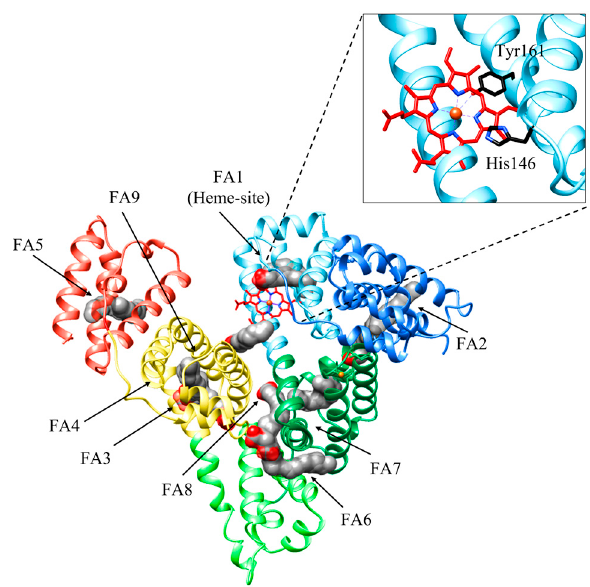
Figure 2. Three-dimensional structure of HSA bound to fatty acids (FAs) and heme. HSA is organized in three domains: domain IA (light blue), domain IB (sky blue), and domain IA (forest green); domain IIA (light green); and domain IIIA (yellow) and domain IIIB (coral). HSA binds up to nine equivalents of FAs, its primary physiological ligands, at sites FA1 to FA9. FAs are rendered as space-fill (gray), whereas the heme is rendered as sticks (red). His141 and Tyr146 residues coordinating the heme-Fe atom are shown in black. The subdomains of HSA are rendered with different colors. The picture has been drawn using the UCSF Chimera package